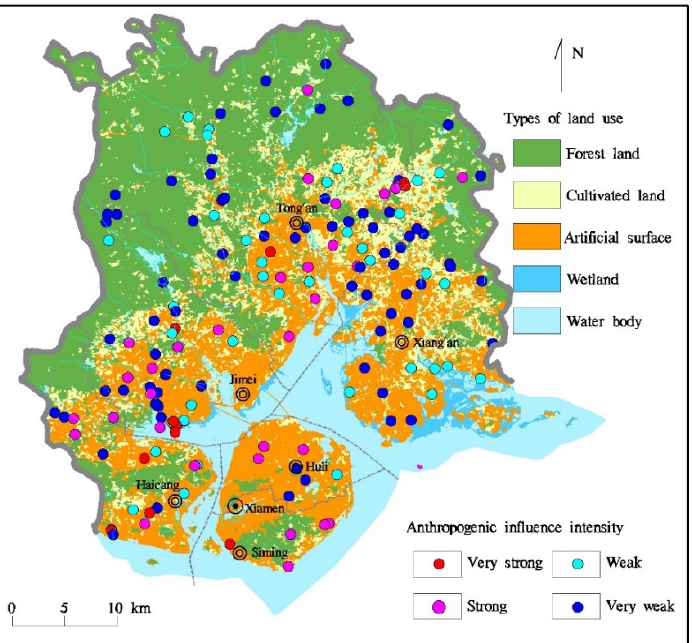
Figure 5. Map showing the distribution of the intensity of anthropogenic influences on groundwa- ter.